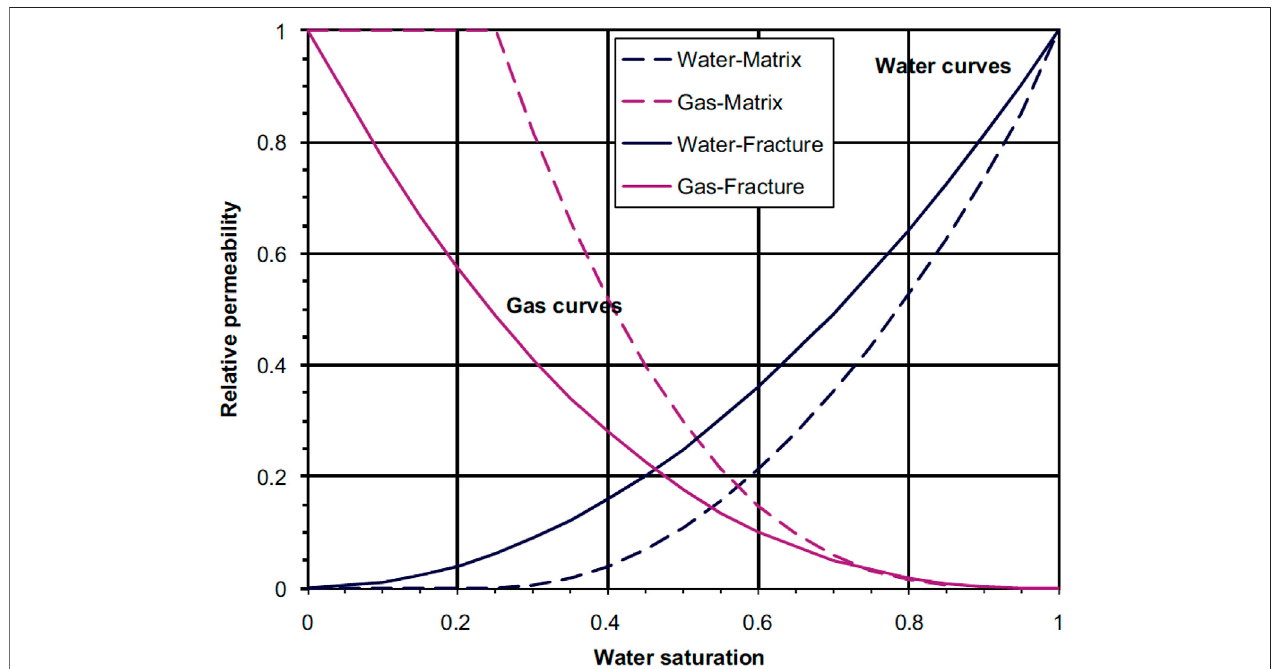
FIGURE 1 | Two sets of relative permeability curves for matrix and fracture systems (Cheng, 2012).